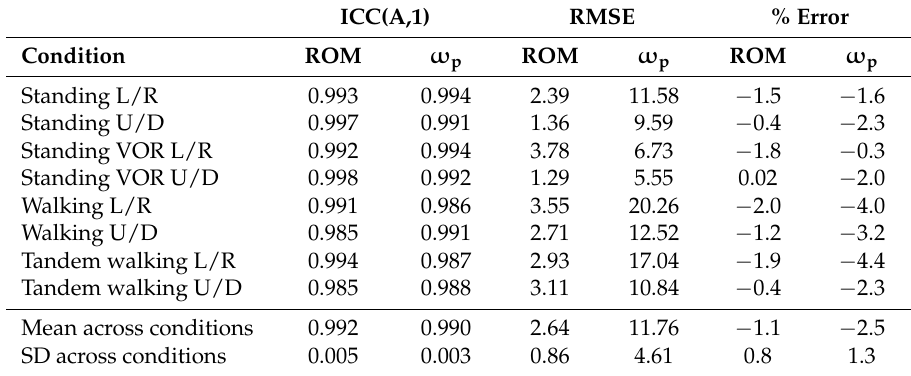
Table 3. Validity results comparing IMU to motion capture for head range of motion (ROM) and peak rotational velocity ( ω p ).